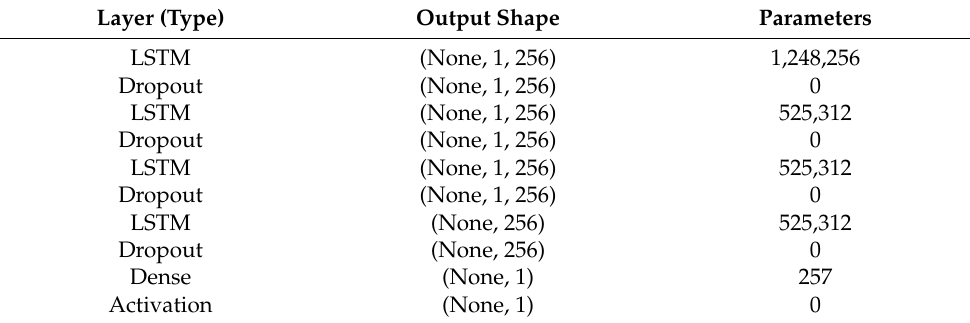
Table 2. Stacked LSTM model